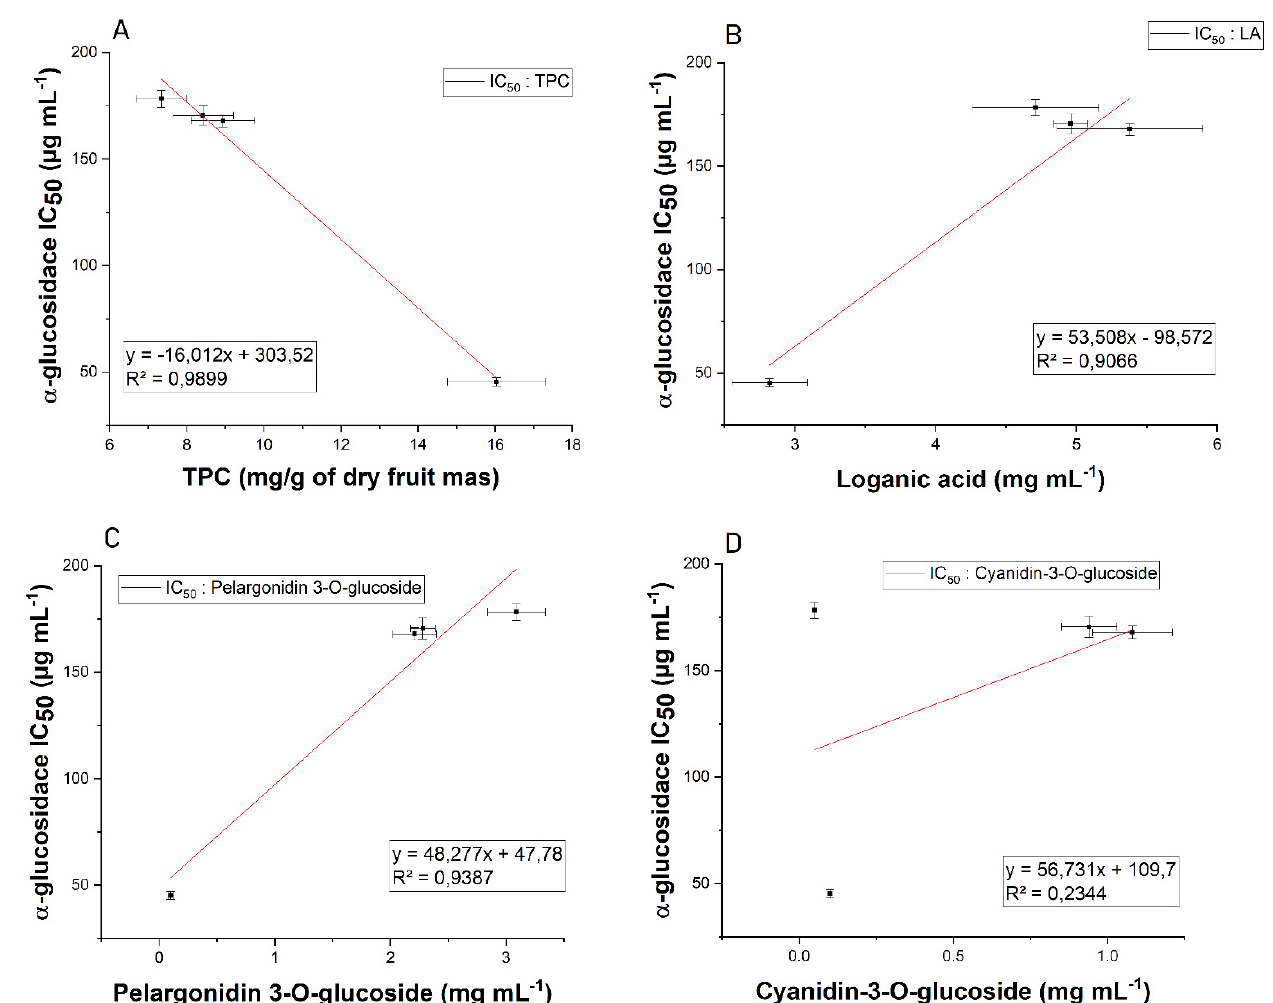
Figure 4. Correlation between α -glucosidase inhibitory activity and TPC ( A ) *, loganic acid ( B ) *, pelargonidin 3- O -glucoside ( C ) *, and cyanidin 3- O -glucoside ( D ) ** content (*—significance with p ≤ 0.05; **- significance with p > 0.05).